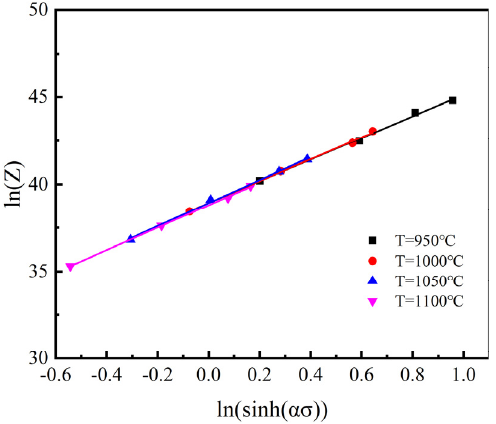
Figure A3. Fitting line, ln A by plotting lnZ vs. ln [ sinh ( ασ )]